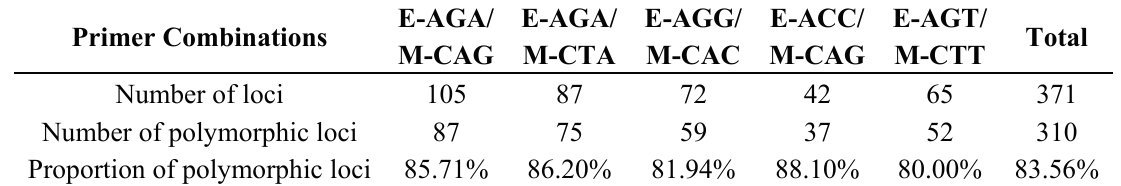
Table 2. Number of bands generated by primer